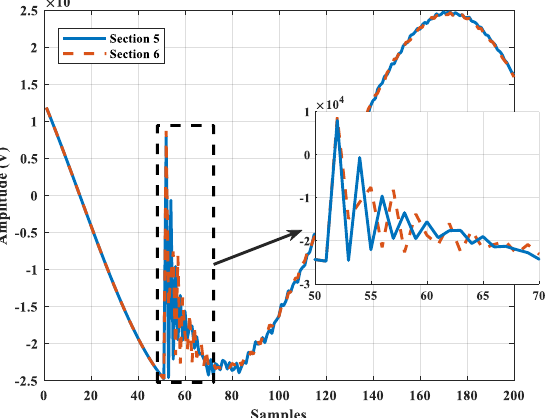
Figure 6. Alpha component of two sample faults in Sections 5 and 6.